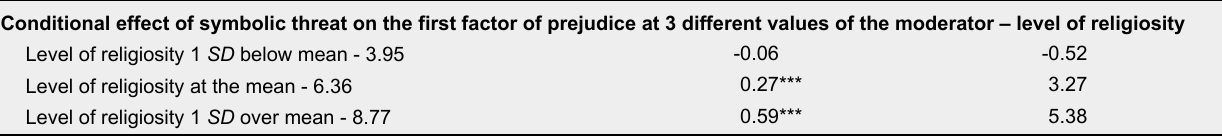
b Coefficients for the Model 2: Symbolic Threat and Religiosity on the First Factor of Prejudice Effect b t Main and interaction effects of predictor variables Symbolic threat